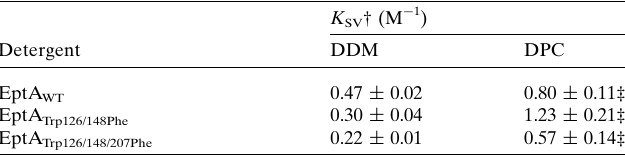
Table 2 Summary of the Stern–Volmer constants ( K SV ) obtained from the intrinsic tryptophan fluorescence quenching of EptA and mutants with iodide.